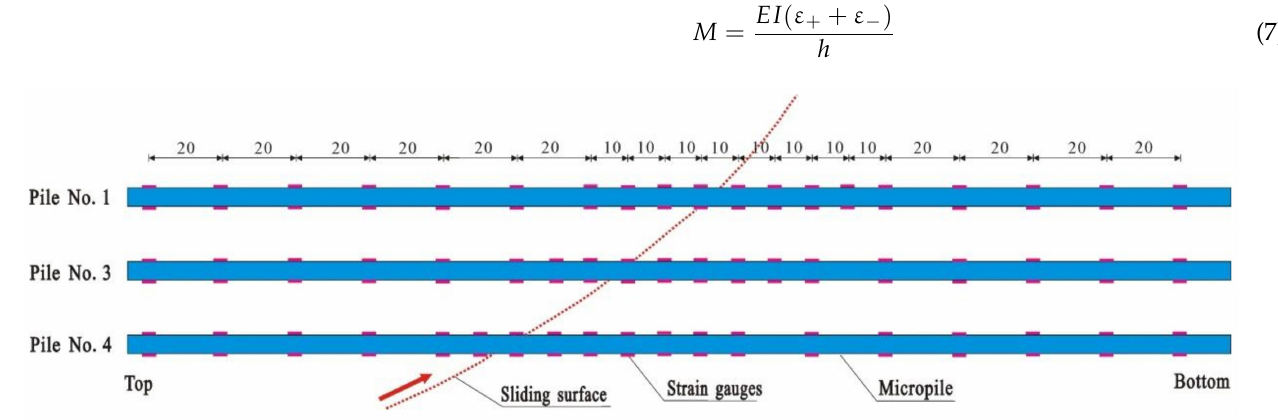
Figure 6. The layout of strain measurement points on the piles (unit: